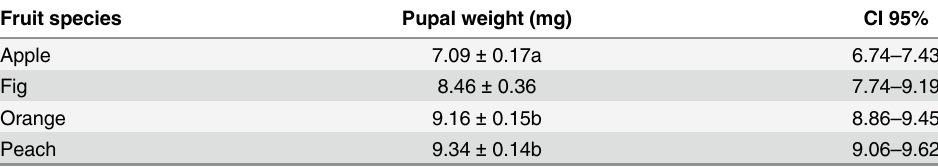
Table 2. Pupal weight (mean ± S.E.) of Ceratitis capitata reared on different fruit species. Fruit species Pupal weight (mg) Apple Fig Orange Peach 9.06 – 9.62 Con fi dence intervals of 95% (CI 95%) are also presented. Means followed by the same letter within the same column do not differ statistically ( α = 0.05; multiple contrasts). Fig was not considered in the statistical analysis because of the larger variation around the